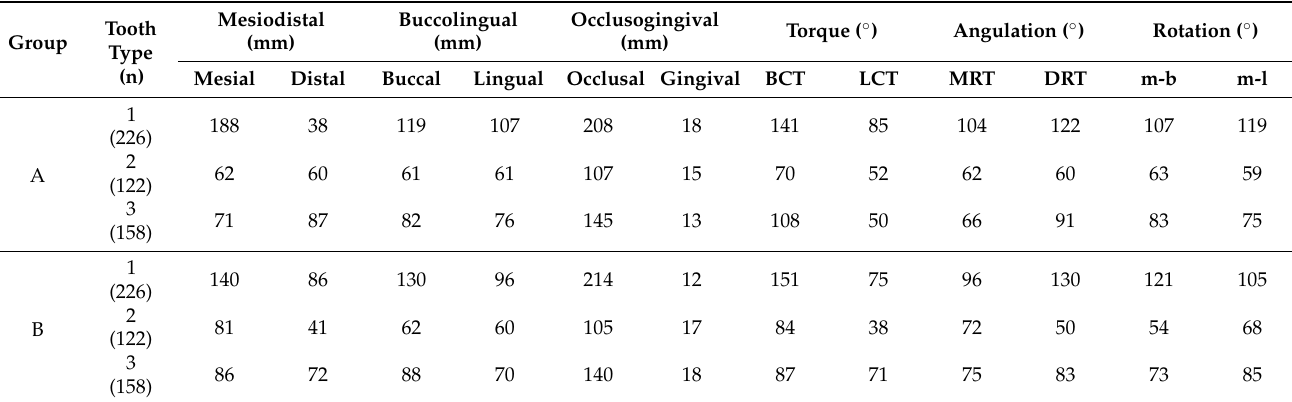
Table 2. Frequencies of directional bias for each experimental